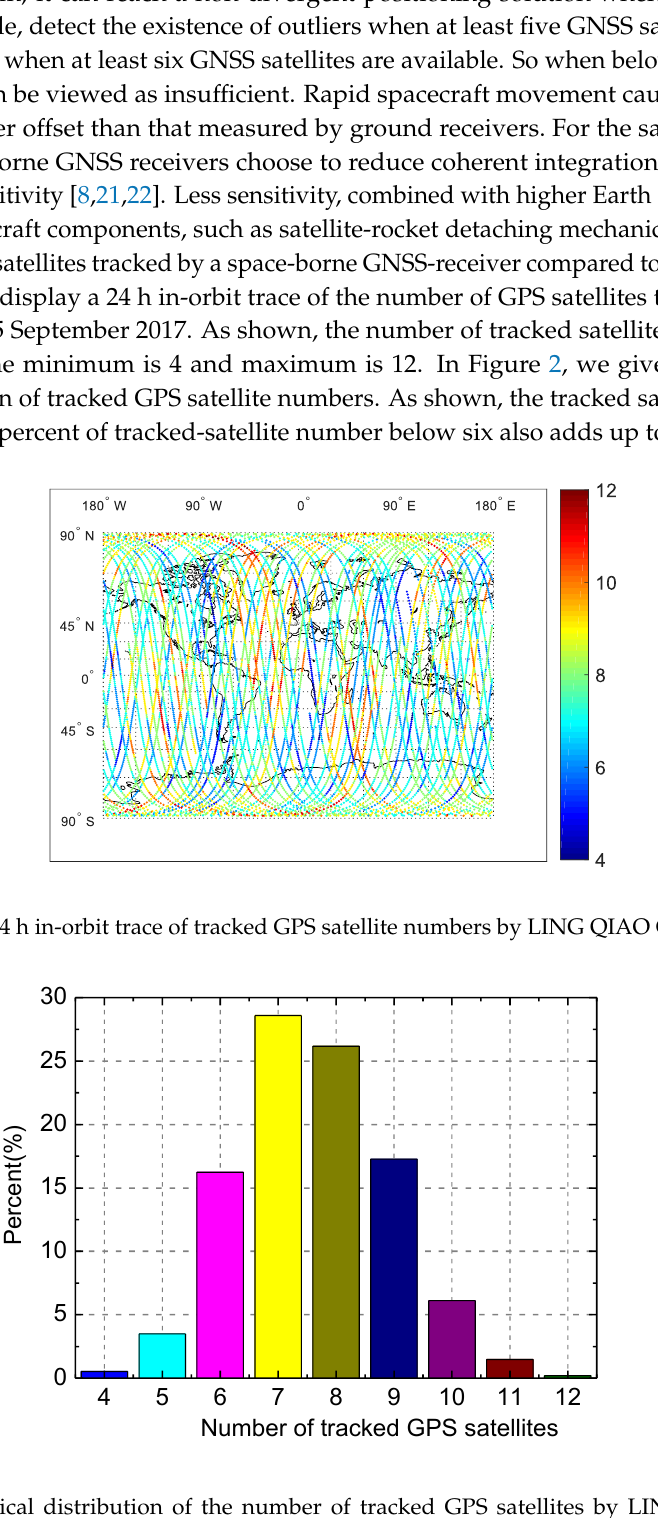
Figure 2. Statistical distribution of the number of tracked GPS satellites by LING QIAO global navigation satellite system (GNSS) receiver on 15 September